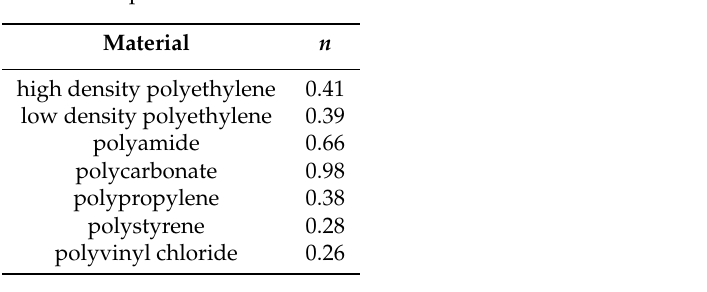
Table 1. power-law